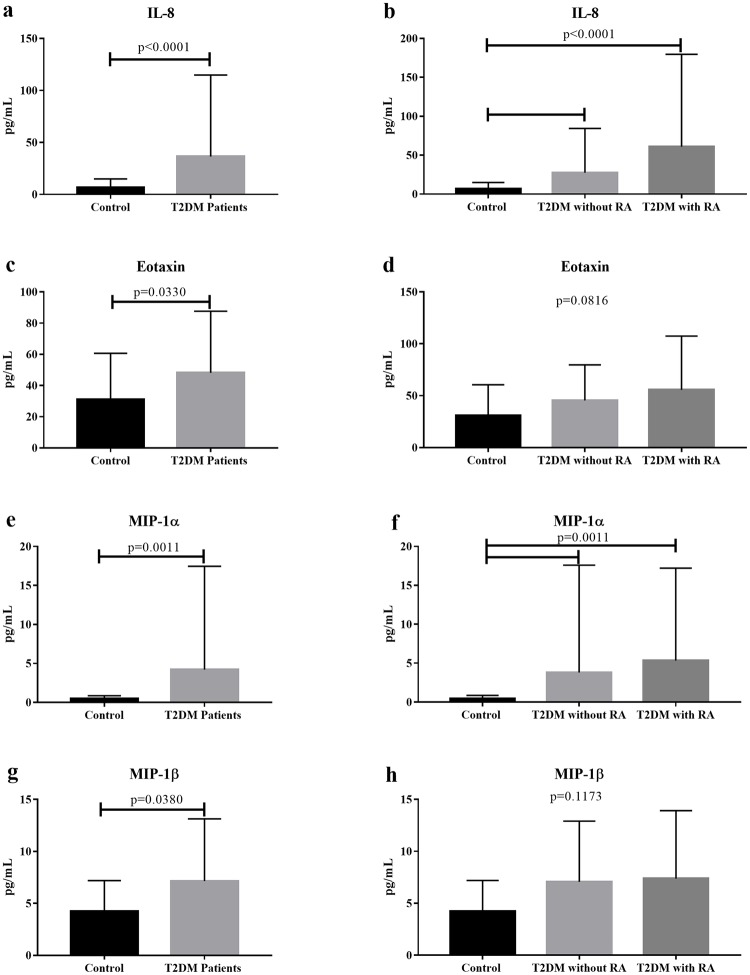
Serum chemokine levels in the T2DM group without and with RA and control group.(a) Serum IL-8 level in T2DM patients and controls and (b) T2DM patients without and with RA vs. controls. (c) Serum eotaxin level in T2DM patients and controls and (d) T2DM patients without and with RA vs. controls. (e) Serum MIP-1α level in T2DM patients and controls and (f) T2DM patients without and with RA vs. controls. (g) Serum MIP-1β level in T2DM patients and controls and (h) T2DM patients without and with RA vs. controls. The results were expressed as mean ± standard deviation. RA, renal alteration.